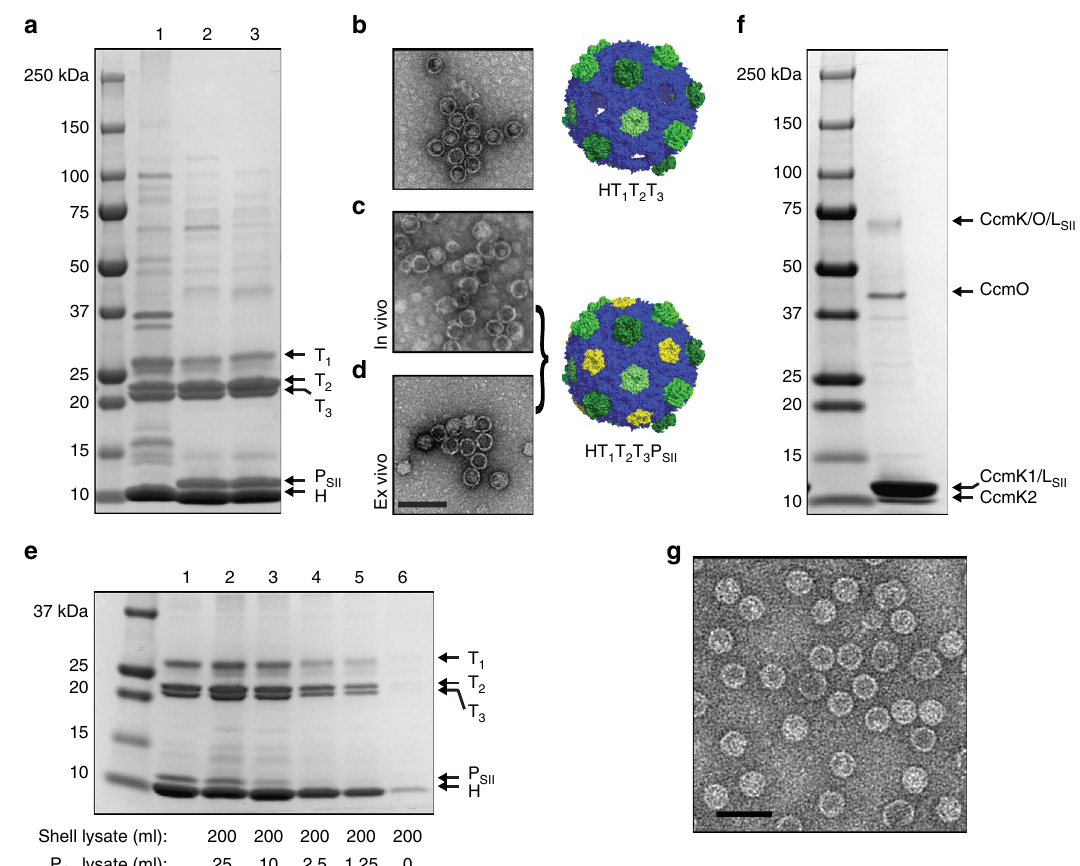
Fig. 1 Comparison of different shell preparation methods. a SDS-PAGE analysis of HO shell preparations. Lane 1: Classic, Lane 2: in vivo capped, Lane 3: ex vivo capped. Shell protein identities indicated by arrows; loading normalized to A280 readings. b – d Negative stain TEM micrographs of three different shell preparations and corresponding structural models. Scale bar = 100 nm. e SDS-PAGE analysis of eluates from pentamer titration experiment. Lane 1: Ex vivo capped shells from Fig. 1a, Lanes 2 – 6: Titration of pentamers with equivalent volumes of each culture used in mixing experiments expressed in milliliters. f SDS-PAGE analysis of Halo carboxysome shell preparation using af fi nity puri fi cation. g Negative stain TEM micrographs of Halo carboxysome shell preparation. Scale bar = 50 nm. Results presented are representative of two independent biological replicates for a – d , f , and g . Findings in fi gure ( e ) recapitulate pilot experiments in which a subset of speci fi ed lysate ratios were